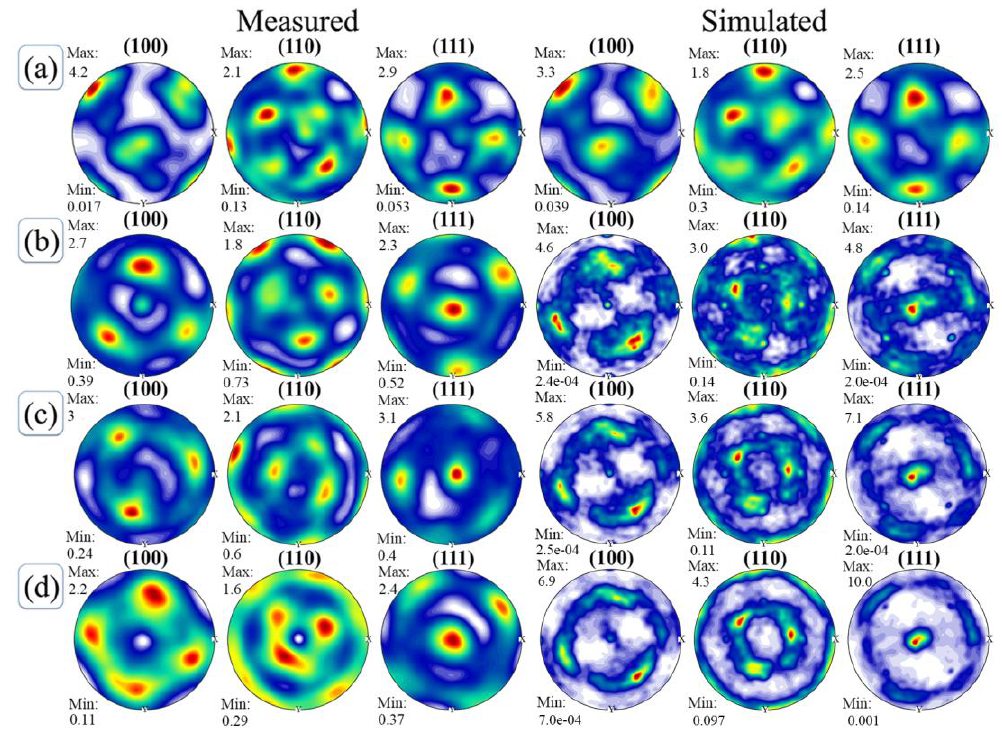
Figure 10. Pole figures showing texture evolution of NiTi SMA subjected to uniaxial compression at various deformation degrees: ( a ) 0%; ( b ) 20%; ( c ) 30%; ( d )